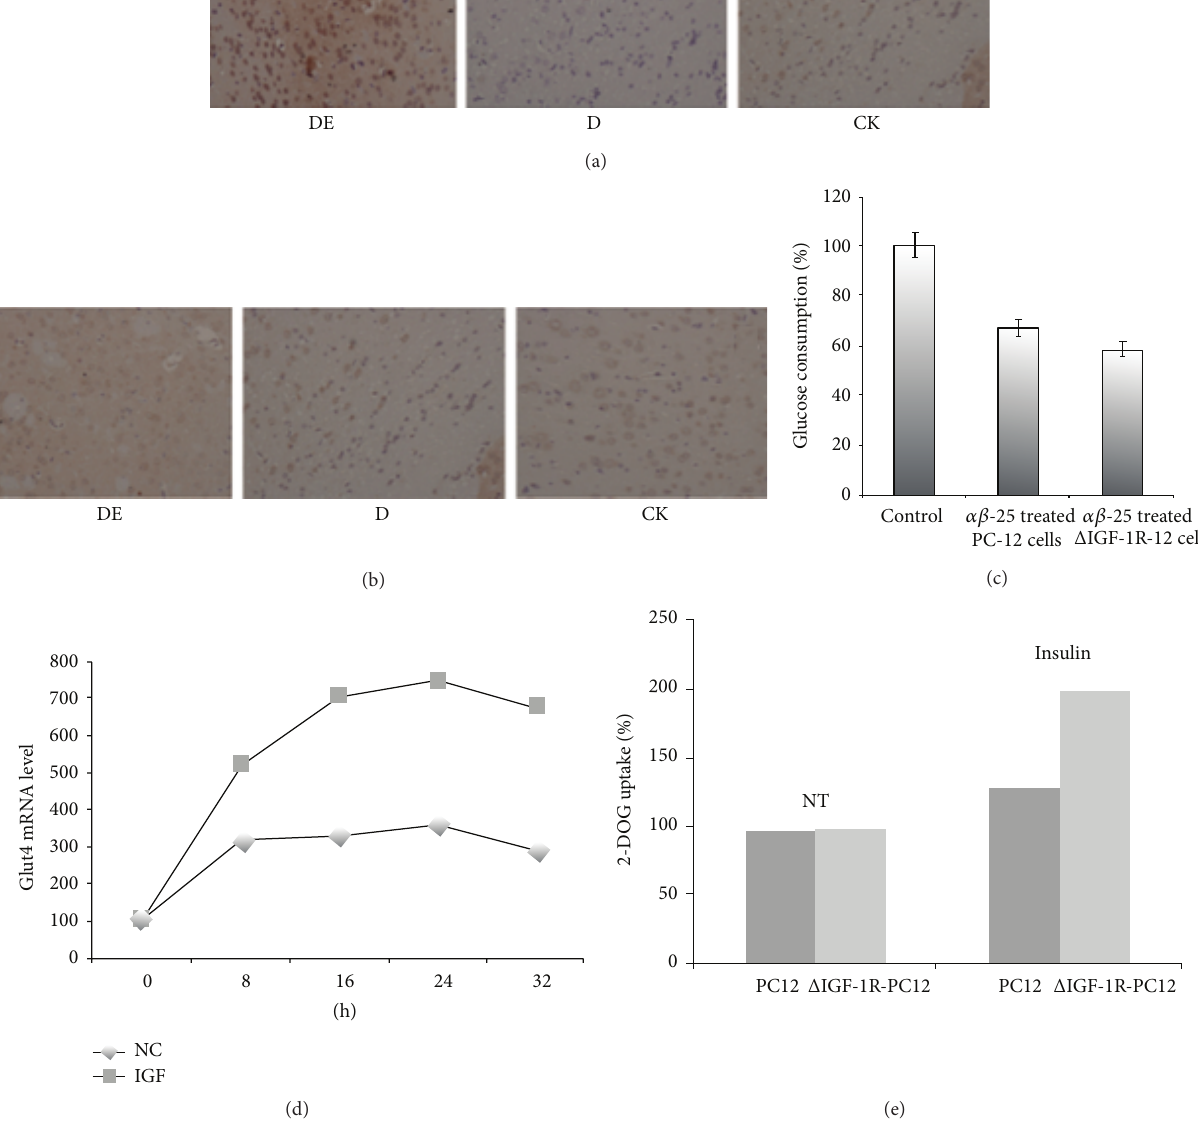
Figure 2: Expression of enhanced IGF-1R (a) and IR (b) in the hippocampal gyrus of DE rats. Enhanced insulin-induced glucose transport in Δ IGF-1R PC-12 cells (c, d, and